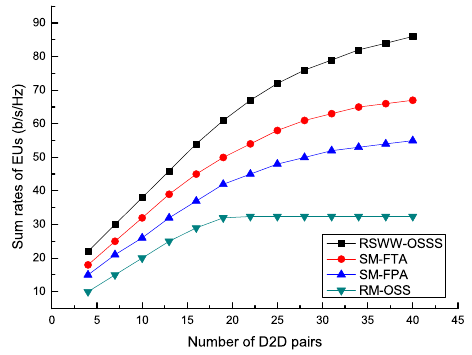
Figure 5. Sum-rate of EUs versus different numbers of D2D transmission pairs when the number of EUs is 20.